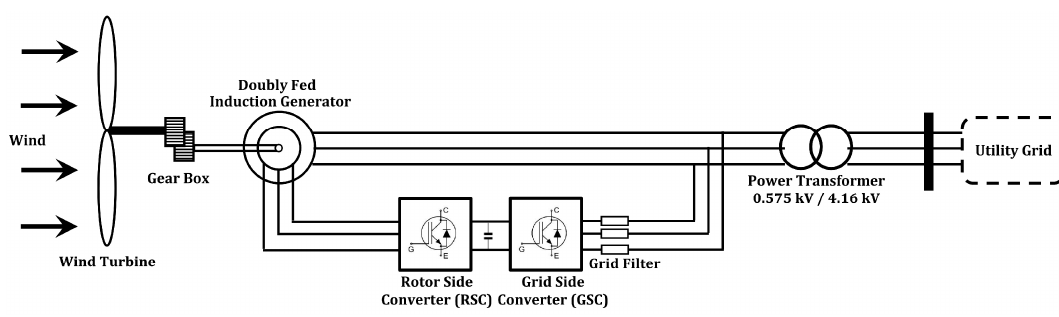
Figure 3. Model of DFIG wind